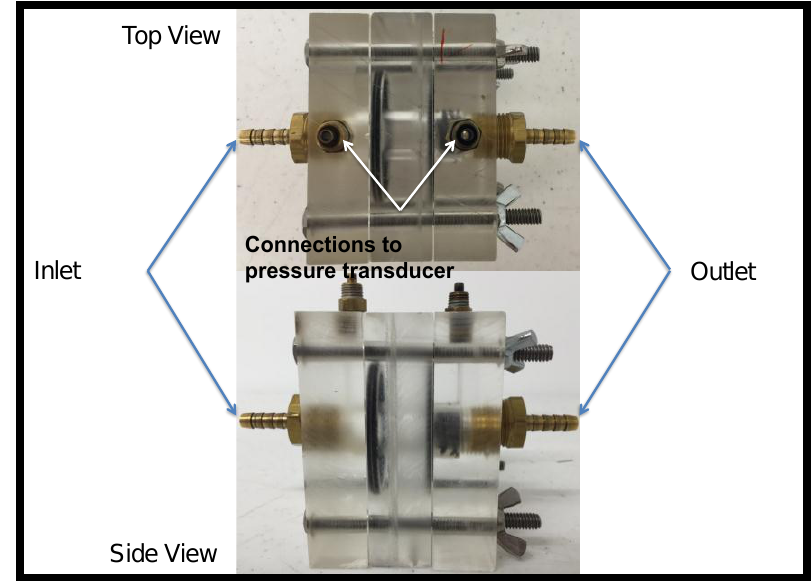
Figure 2. Dispersion setup: Two centrifugal pumps were used, the first pump was used for circulating water-diesel mixture in the dispersion tank and the other pump was used to pump the dispersion to the filter medium.